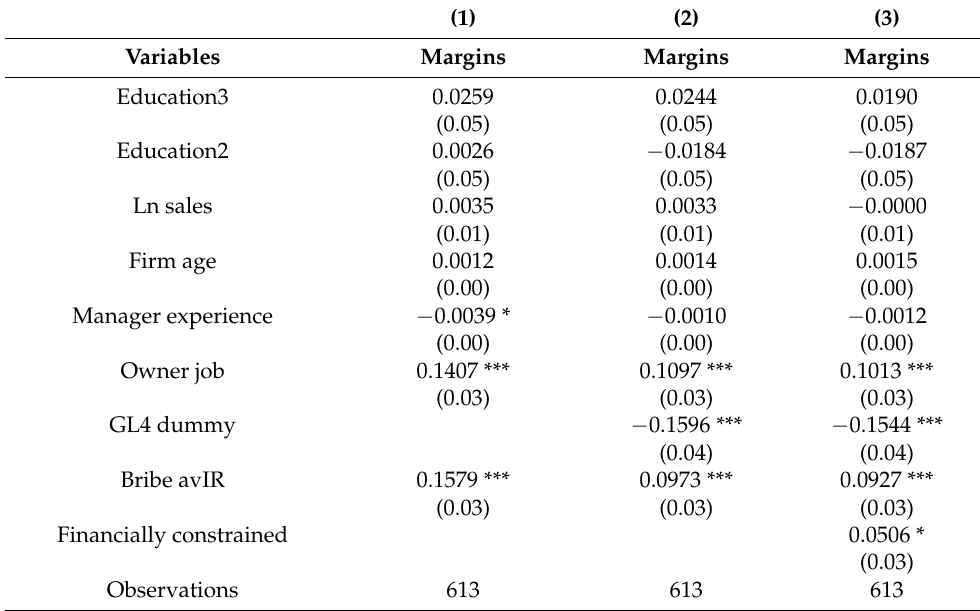
Table 7. Marginal effects of factors affecting female entrepreneurship: robustness